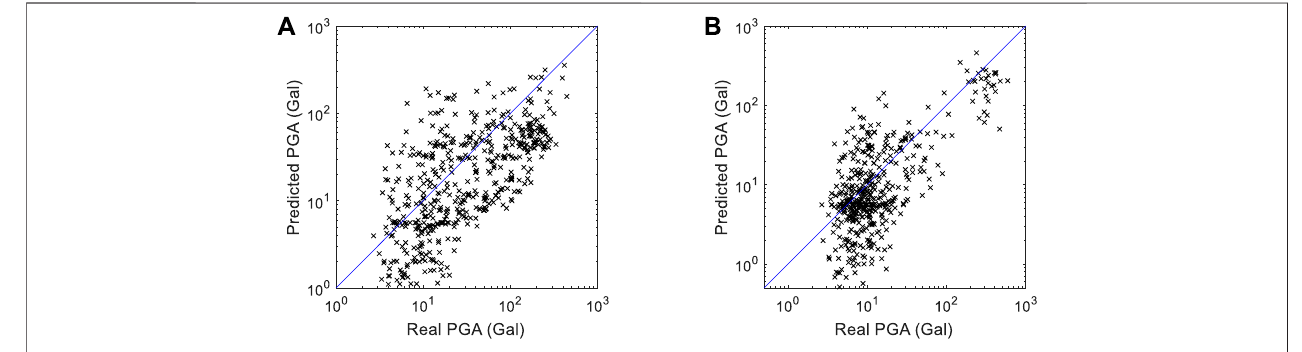
FIGURE 12 | Comparison between the predicted PGA and actual PGA of the (A) Meinong data set, and (B) Hualien data set.